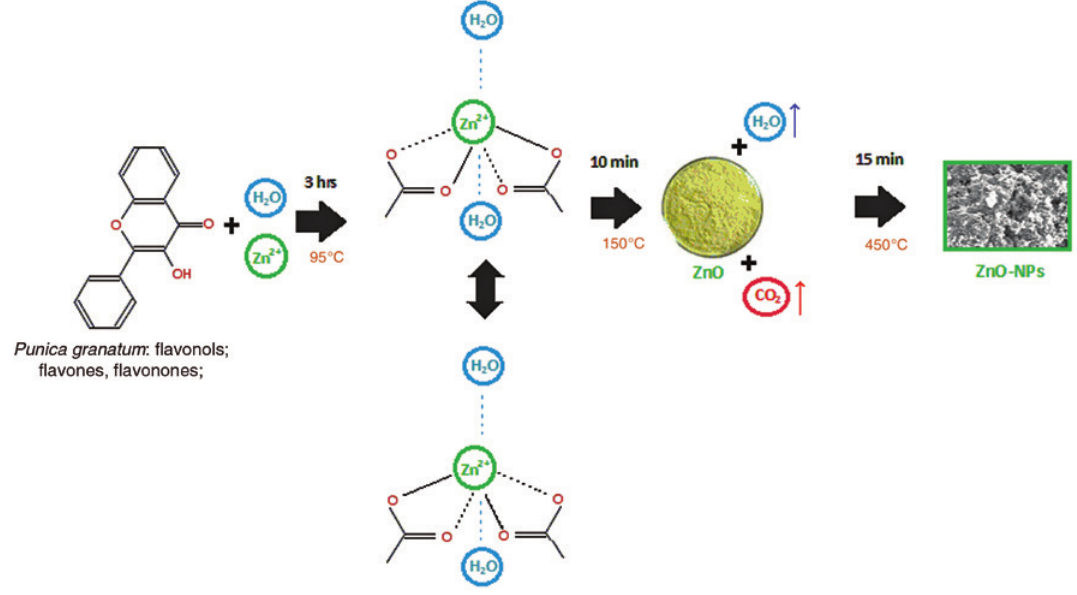
Figure 2: Possible reaction for production of zinc oxide nanoparticles (ZnO-NPs) [22].